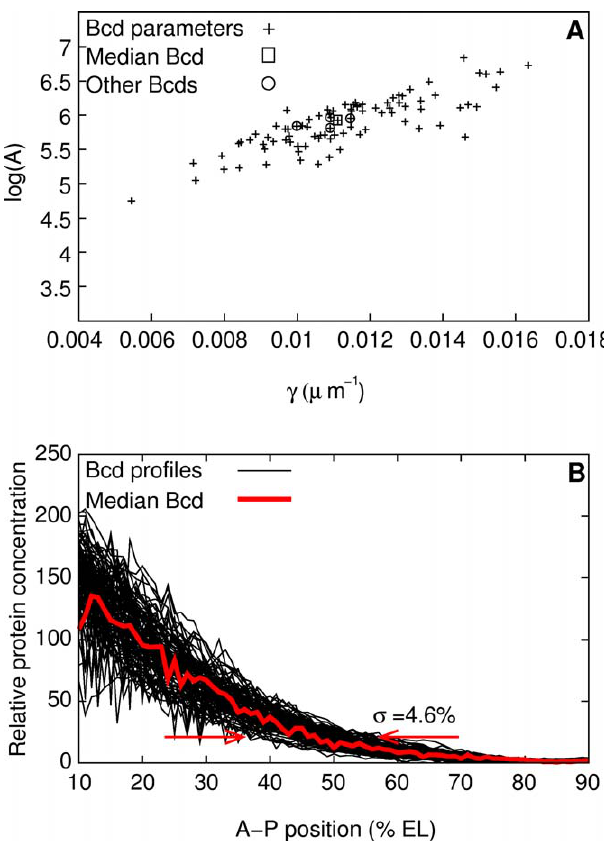
Figure 2. Selection of a Representative Bcd Profile (A) Scatter plot of log amplitude (log A ) and slope ( c ) of 88 Bcd profiles from cycle 13 embryos. The boxed profile and the circled profiles were investigated further; unless explicitly mentioned, the analysis in this paper uses the boxed (median) profile. (B) An overlay of all 88 Bcd profiles used in the simulations. The median profile is highlighted in red. The threshold concentration at which the Hb border forms in the gene circuit was determined from the median profile. The positions at which these 88 profiles cross that threshold has a range of 20.6% EL, and a standard deviation ( c ) of 4.6% EL.